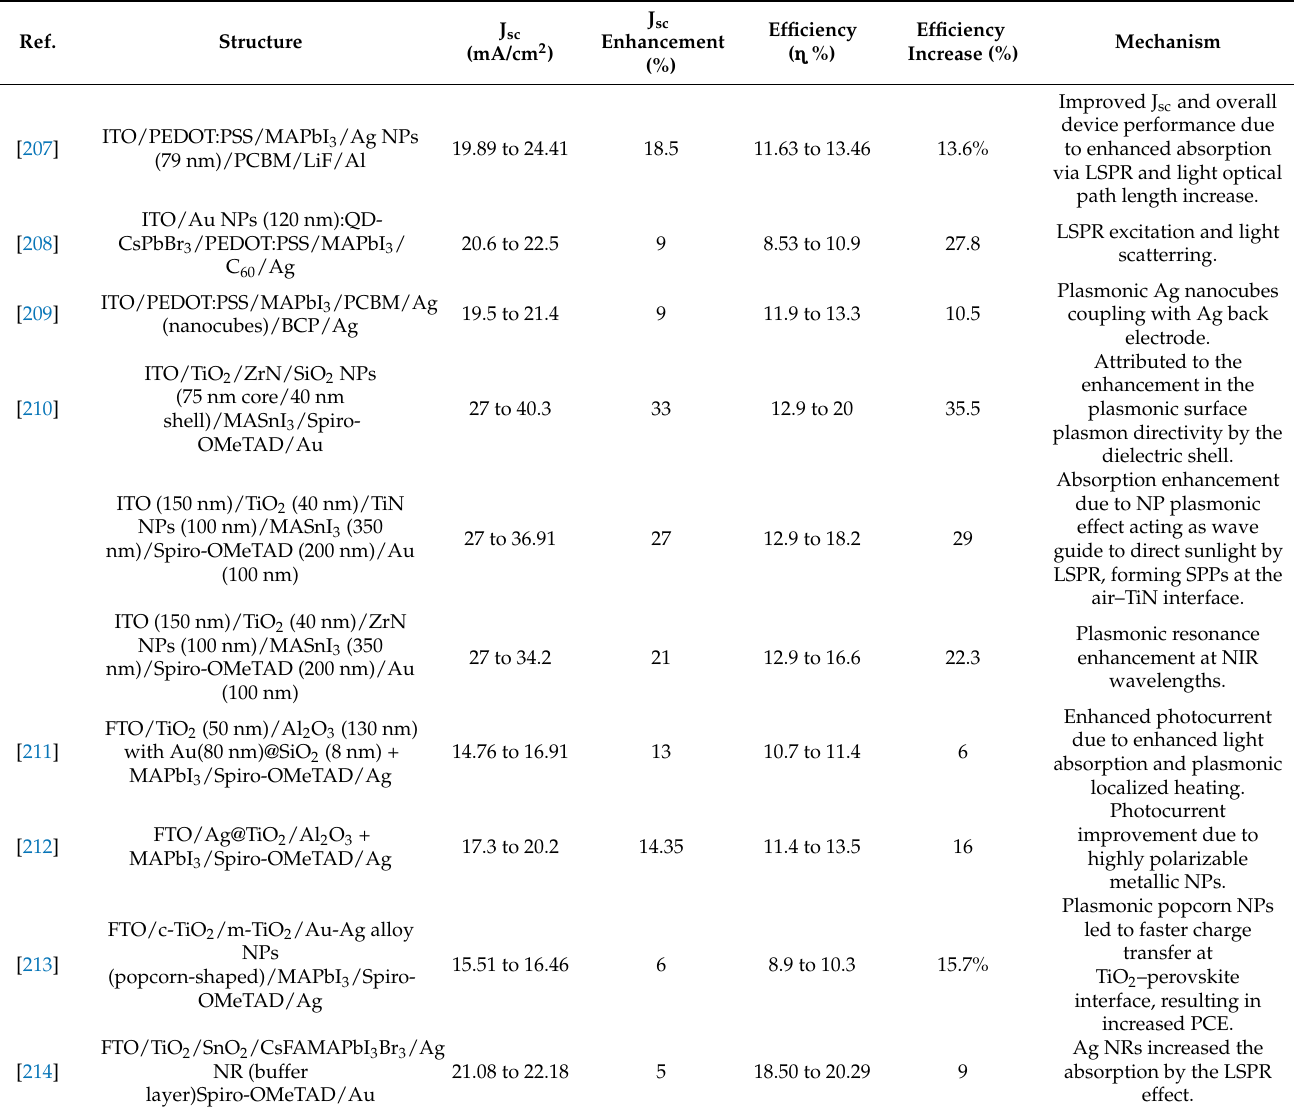
Table 2. Summary of studies in which plasmonic nanoparticles were applied in metal-halide per- ovskite solar cells along with the resulting PV